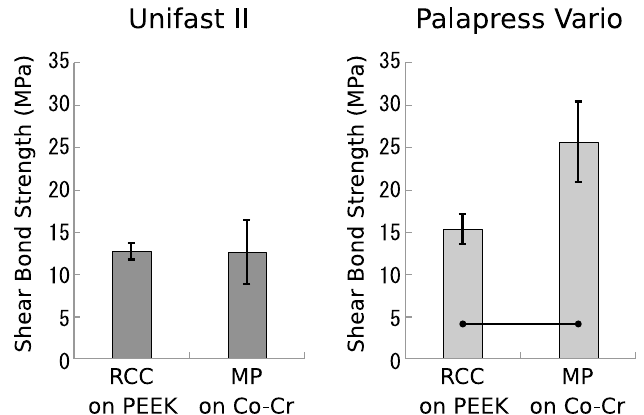
Figure 3. Means and standard deviations of shear bond strengths for PEEK and Co-Cr alloy bonded to resins. Bar indicates a significant difference ( p < 0.05).